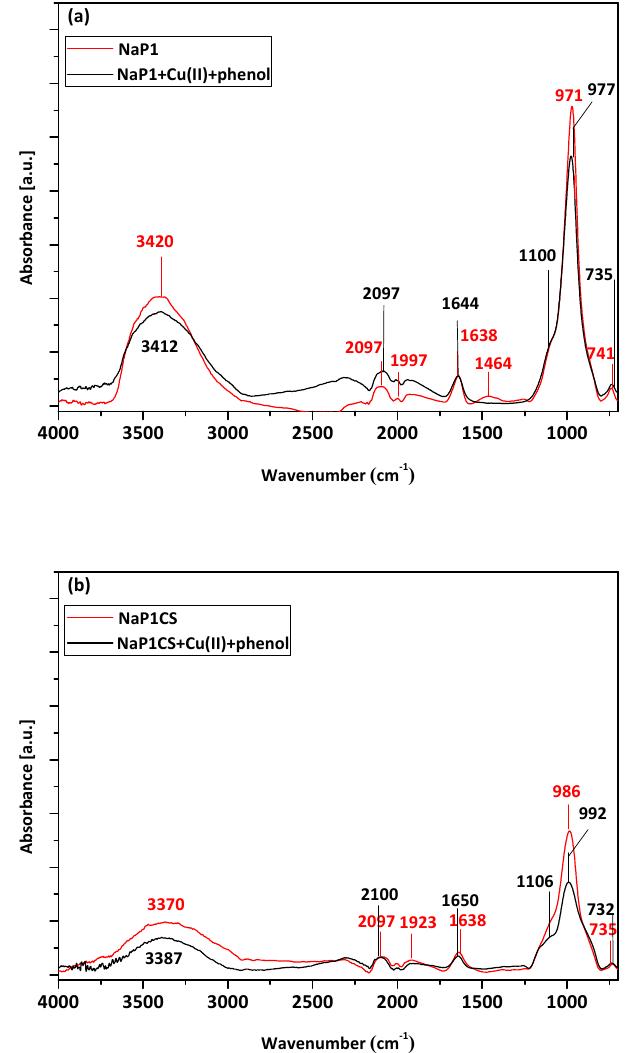
Figure 3. ATR-FTIR spectra of ( a ) raw NaP1 and NaP1 after sorption of Cu(II) ions and phenol, and ( b ) raw NaP1CS and NaP1CS after sorption of Cu(II) ions and phenol.